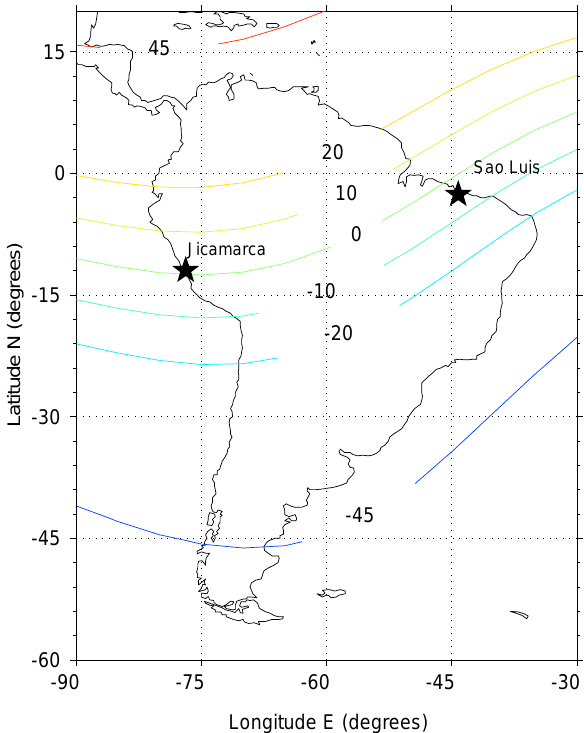
Fig. 1. Location of the São Luís radar whose measurements of 150km echoes were used to derive vertical drifts in the Brazilian sector. The location of the Jicamarca Radio Observatory and the inclination of the geomagnetic field lines are are also shown for reference.